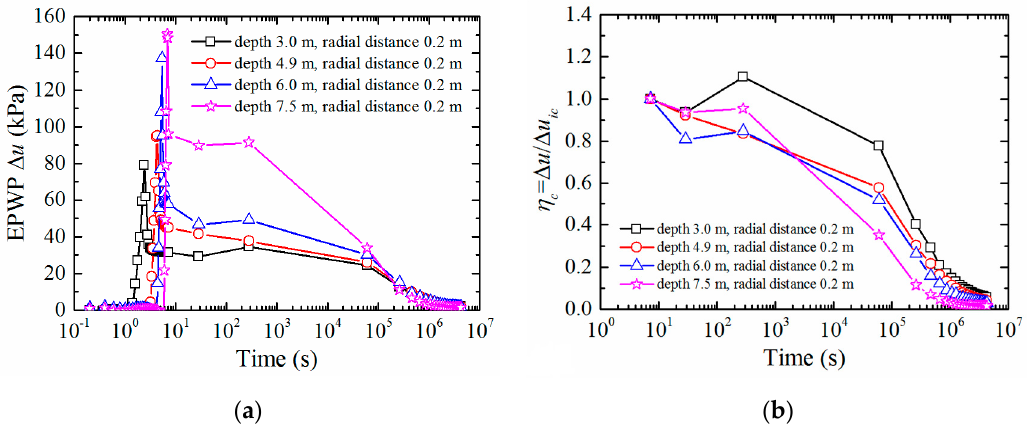
Figure 8. ( a ) Development and dissipation of EPWPs during and after pile installation at different depths; ( b ) Dissipation of normalized EPWPs after pile installation at different depths.